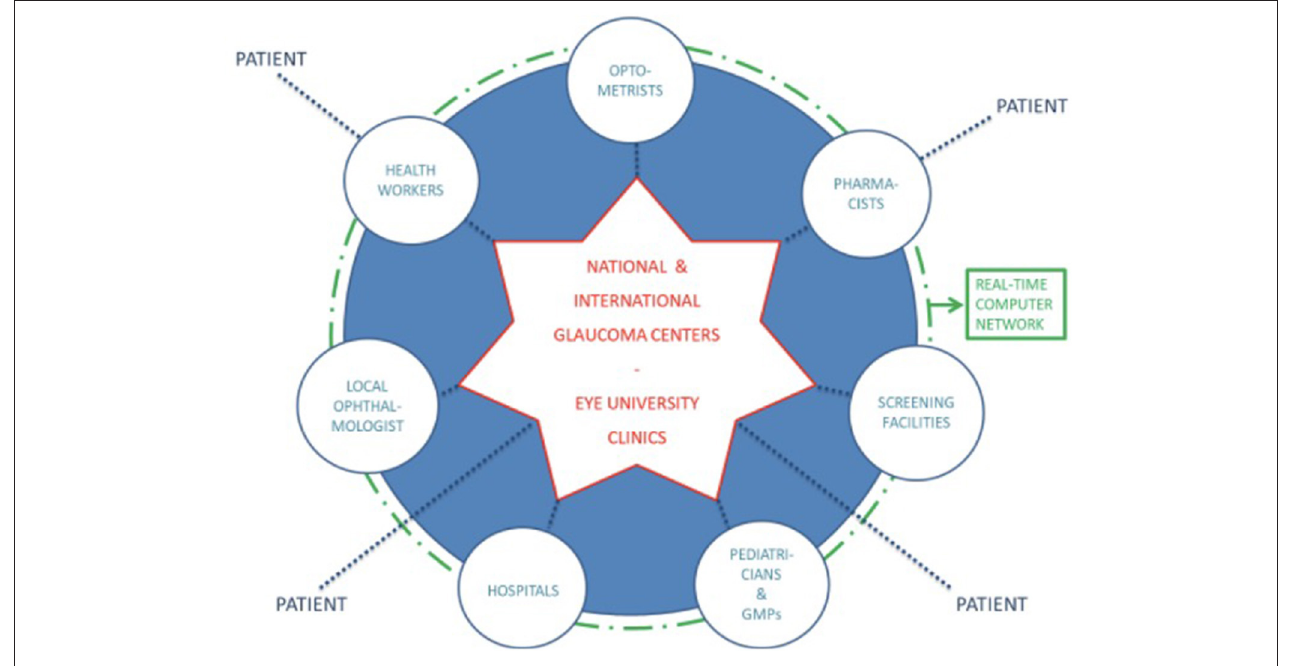
FIGURE 3 | The hub and spoke model of glaucoma